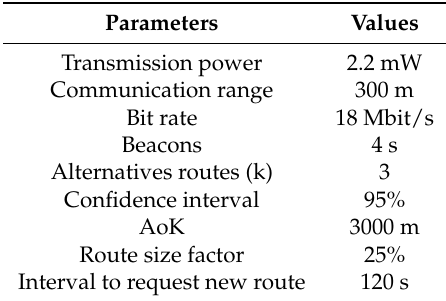
Table 3. Simulation